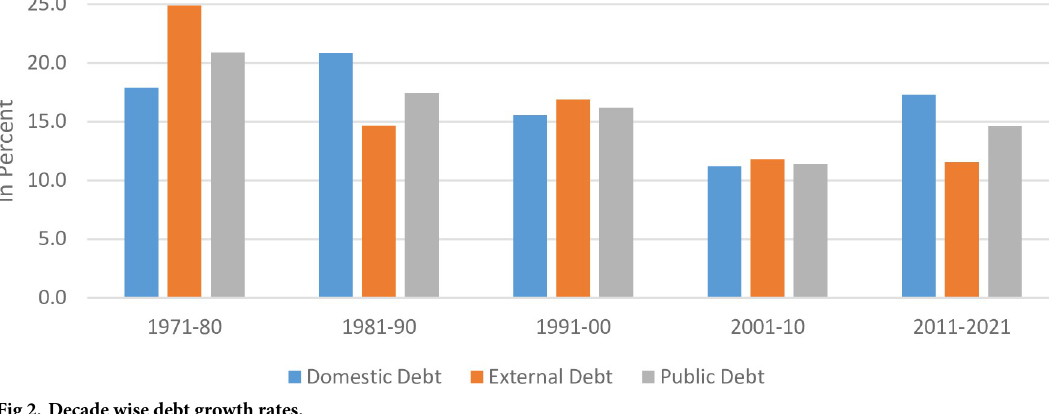
Fig 2. Decade wise debt growth